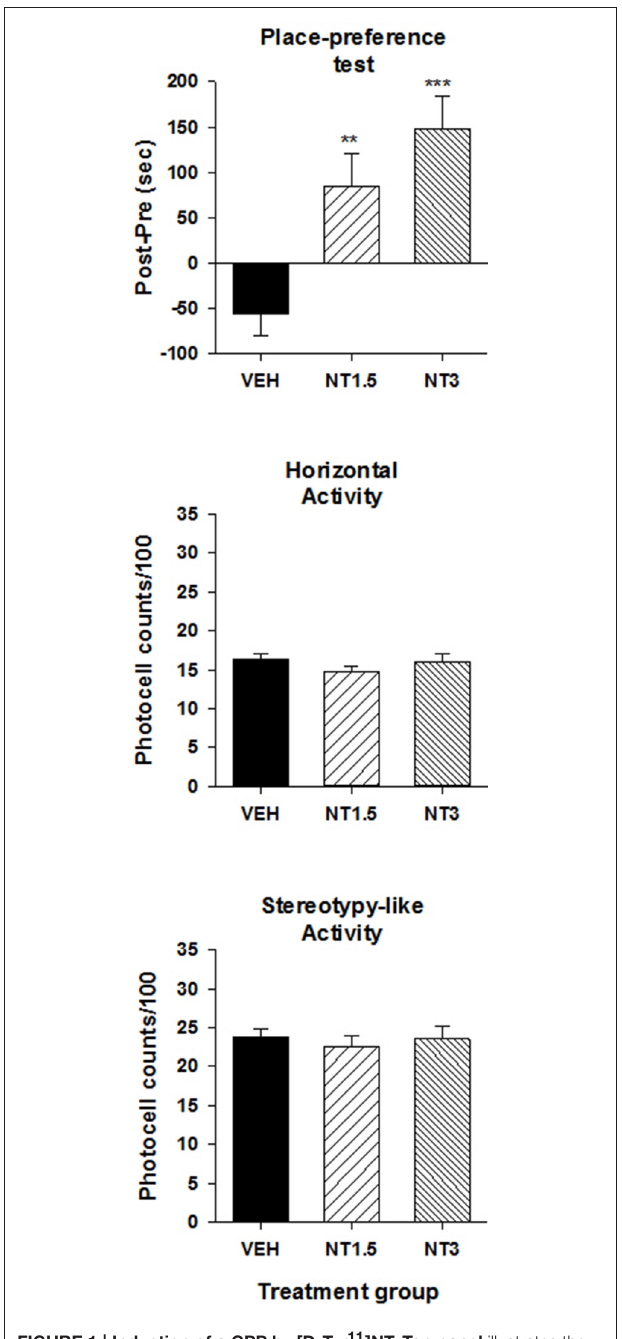
FIGURE 1 | Induction of a CPP by [D-Tyr 11 ]NT. Top panel illustrates the preference score measured on the test day for the animals that were injected with 1.5nmol (NT1.5, n = 6 ), 3nmol (NT3, n = 13 ) of [D-Tyr 11 ]NT or its vehicle (VEH, n = 15 ). Preference score corresponds to the amount of time (in sec) spent in the paired compartment on the test day minus the time spent at baseline in the same compartment. Measures of locomotor activity recorded during the preference test for the animals in each treatment group are presented in the middle panel (horizontal) and bottom panel (stereotypy-like). Asterisks indicate a statistical significant difference with VEH ( ** p < 0.01 ; *** p < 0.001 ).